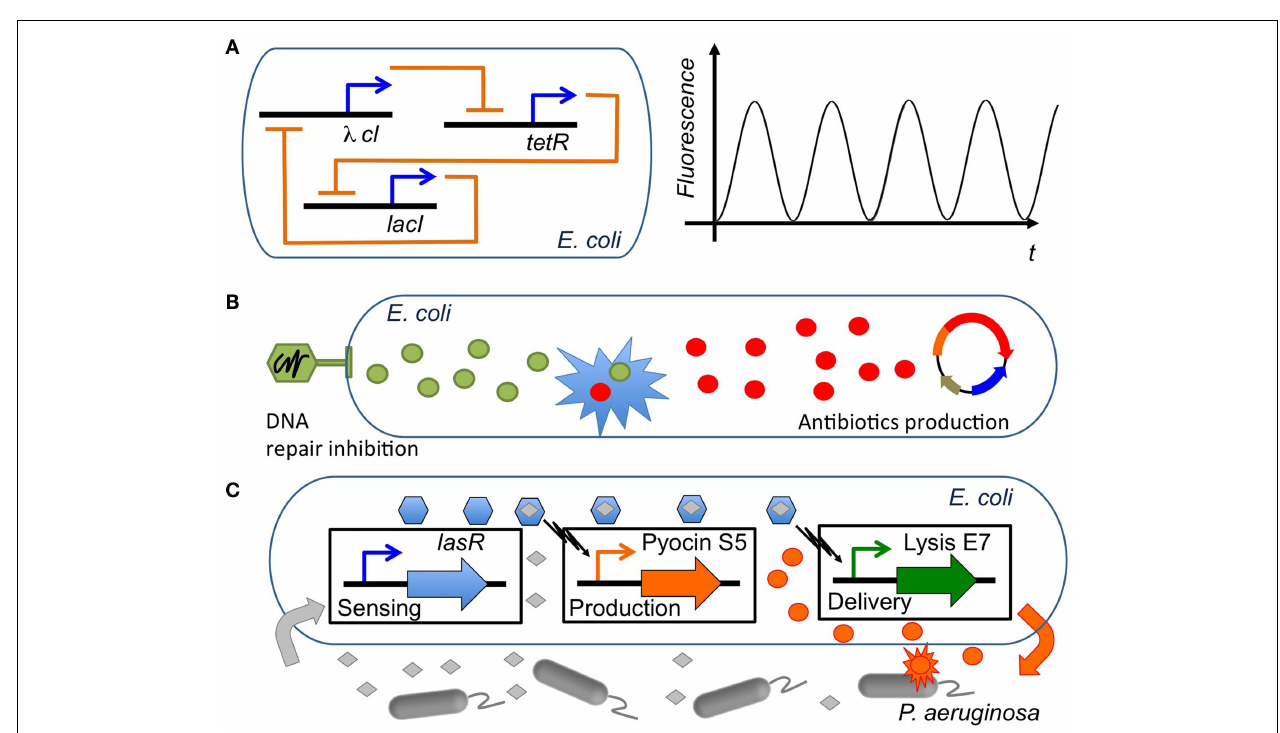
and Collins, 2009) can induce the synergistic effect of lowering tolerance to antibiotics.Thus, the antimicrobial effect of an engineered genetic circuit producing antibiotics (Planson et al., 2011) can be significantly increased. (C) Modular synergy: a combination of three modules that sense the presence of P. aeruginosa , produce the antibiotic pyocin S5 and deliver the antimicrobial by triggering lysis of the cell, respectively, acts synergistically to kill the pathogen when its presence is detected (Saeidi et al.,